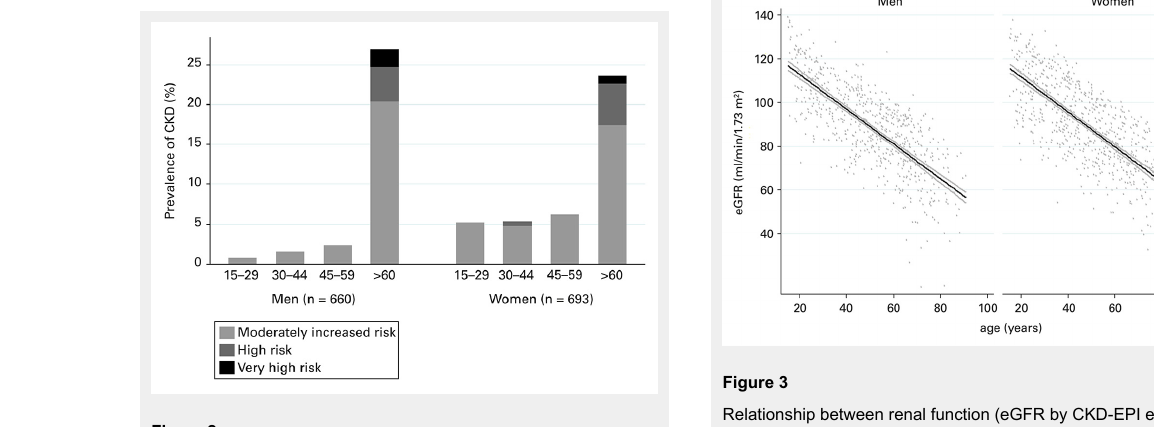
Relationship between renal function (eGFR by CKD-EPI equation) and age in the Swiss population. Bold lines represent the unadjusted linear regression estimation, gray lines 95% confidence interval. Decline slope (SE): –0.79 (0.03) ml/min/1.73 m 2 /year for men, –0.80 (0.03) ml/min/1.73 m 2 /year for women CKD-EPI = Chronic Kidney Disease Epidemiological Collaboration